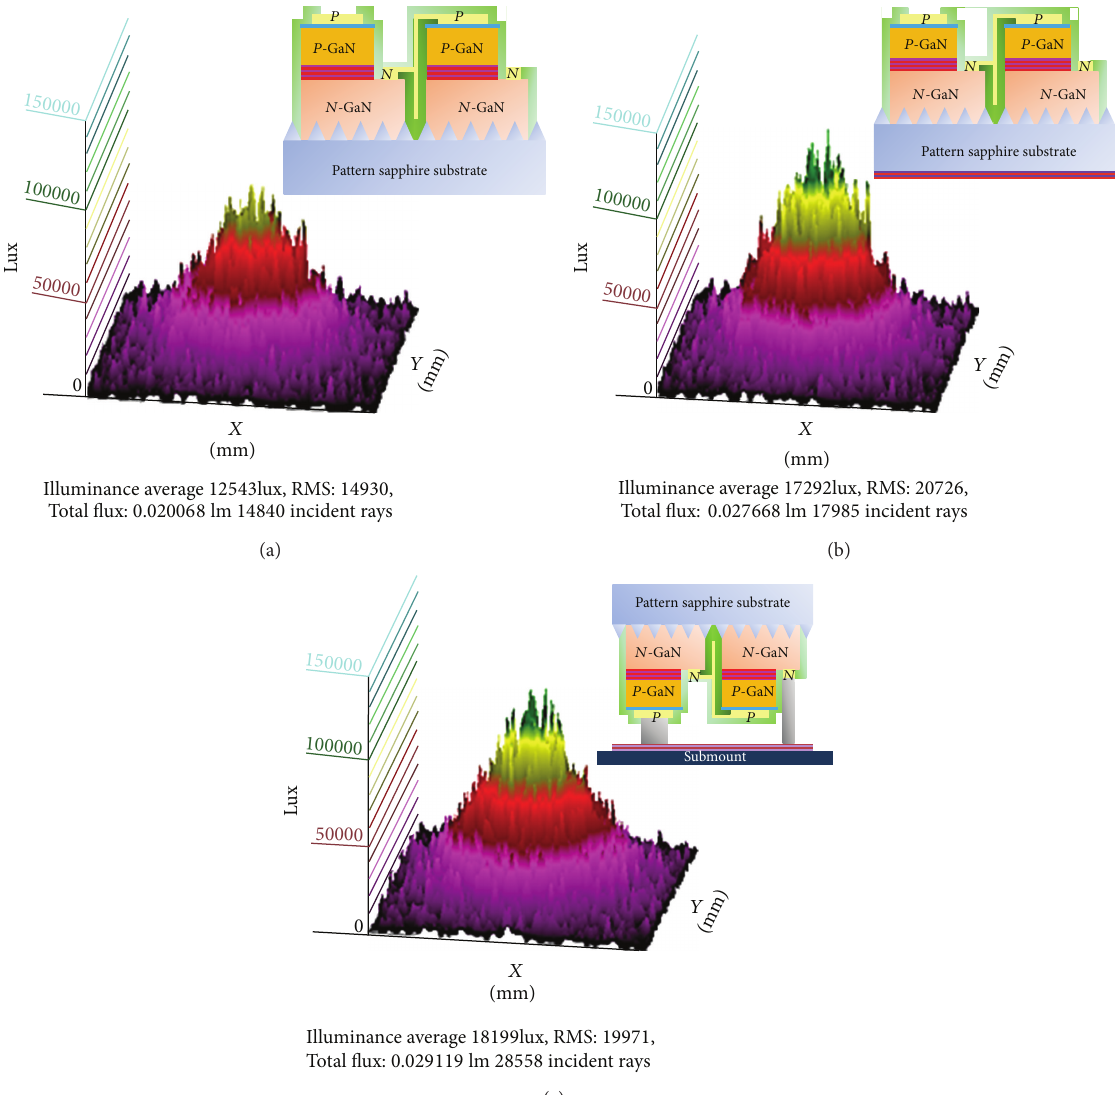
Figure 6: Simulated results of (a) the conventional HV-LED, (b) HV-LED + ODR, and (c)